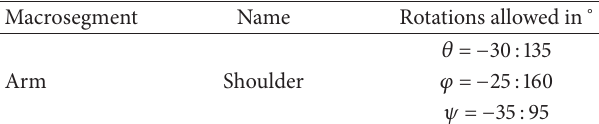
Table 1: Shoulder rotations